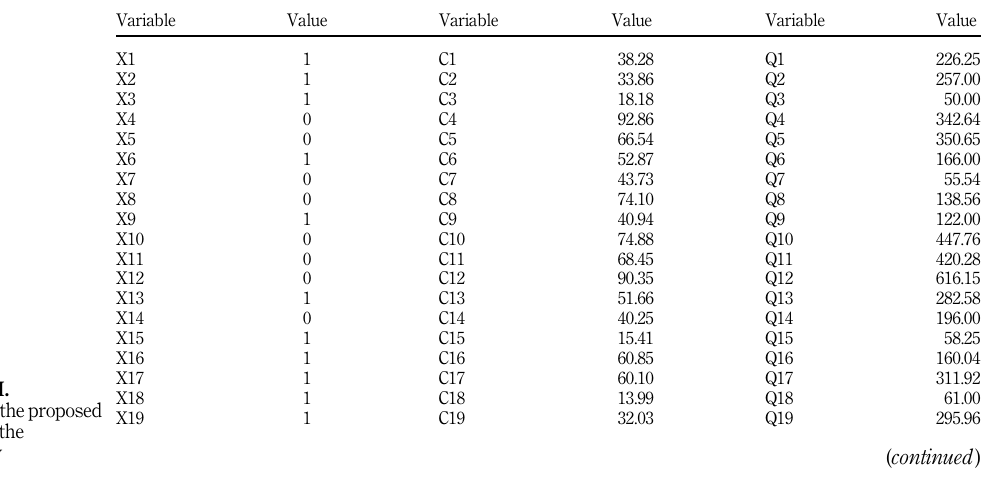
Table VI. Parameters of the proposed model for the case study